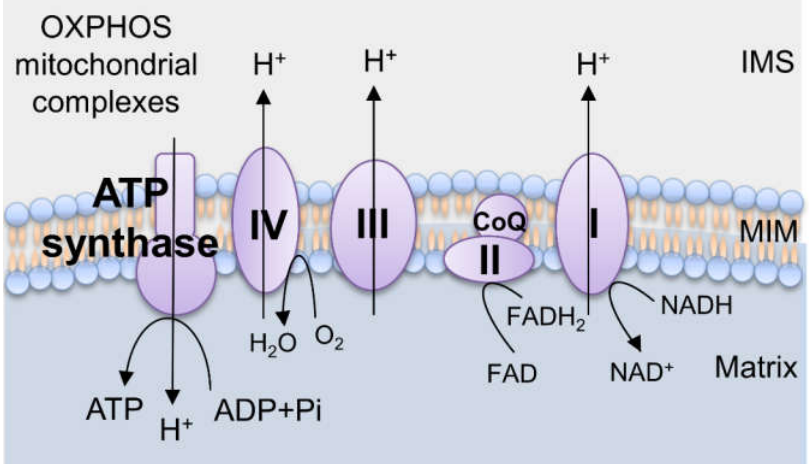
Figure 1. A schematic illustration of the OXPHOS system . There are five main protein complexes involved in OXPHOS: the mitochondrial complexes I-IV and F0F1 ATPase. As electrons are transported through the mitochondrial complexes (I-IV) in a series of redox reactions, energy is transferred to transport protons across the mitochondrial IM, creating an electrochemical potential to drive protons back to the mitochondrial matrix through the F0F1 ATPase and transform ADP to ATP (phosphorylation). OXPHOS, oxidative phosphorylation; IMS, intermembrane space; IM, inner membrane.